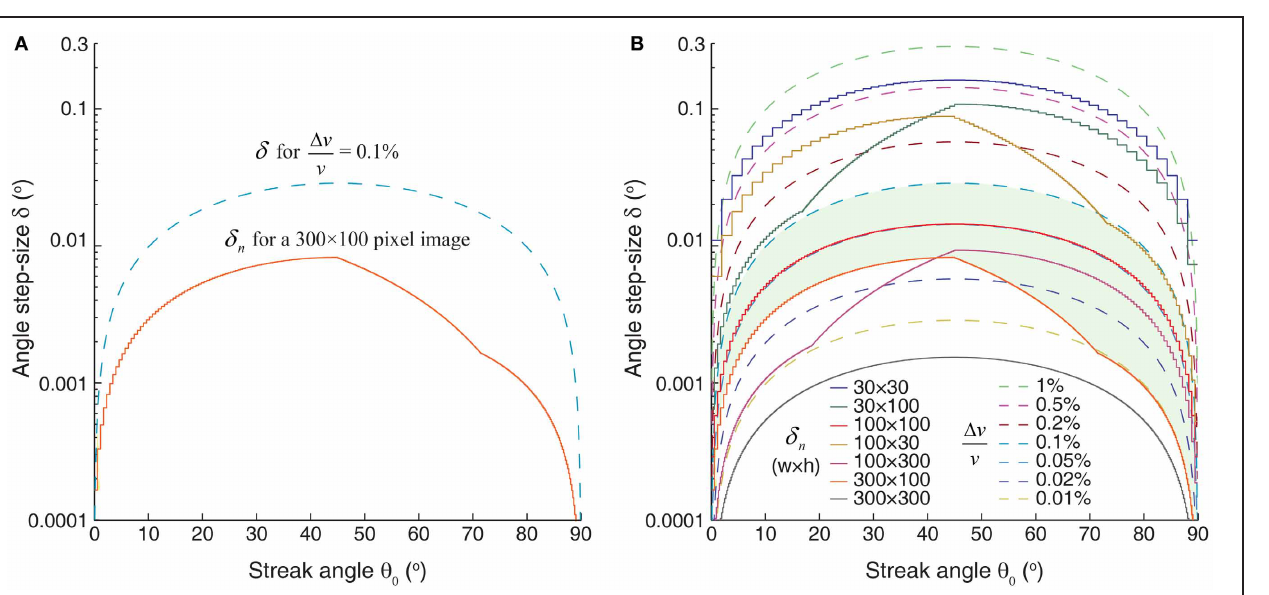
FIGURE 6 | Detection of fractional change in the velocity is dependent on the RBC streak angle and image dimensions. (A) Range of angle step-sizes ( δ ) that can be used inorder to detect fractional change in the velocity ( (cid:2) v / v ) of 0.1% ona300 × 100 pixelimage.Upper limitof δ that canbeused isdelineated by the blue dashed line. The solid orange line demarcates the detection sensitivities of -change in the angle ( δ n ) that can be resolved on image dimensions of 300 × 100 pixels for given streak angles. δ -values between these twocurved linesshould be used inorder detect (cid:2) v / v of0.1%. (B) Limits